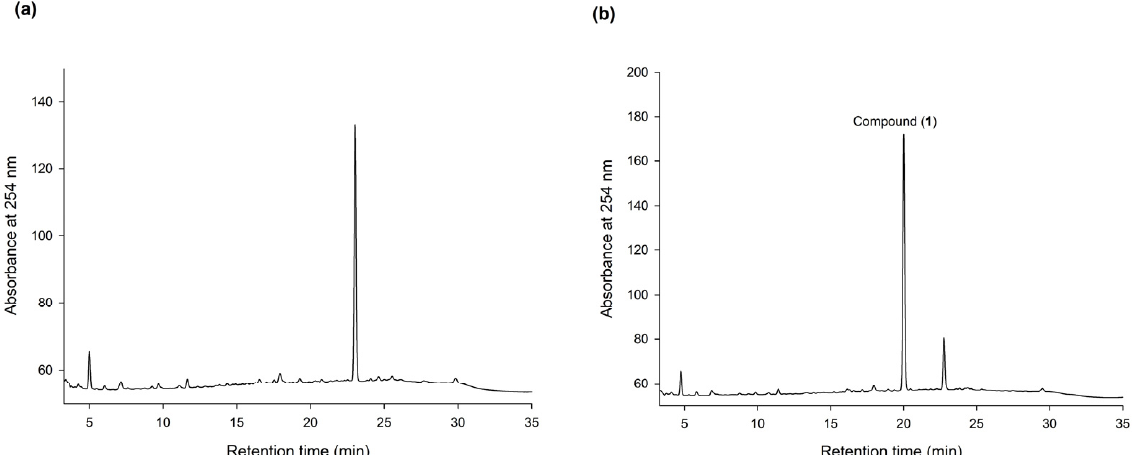
Figure 2. HPLC analysis of the methanol extract of Sun Ten Ha-Soo-Oh herb medicine ( a ) and the biotransformed products by using Bm TYR ( b ). The biotransformation mixture—containing 120 μ g/mL of the purified recombinant Bm TYR enzymes, 2 mg/mL of the extract, 10 mM of ascorbic acid, and 500 mM of borate buffer at pH 9—was incubated at 50 °C and shaken at 200 rpm for 1.5 h.